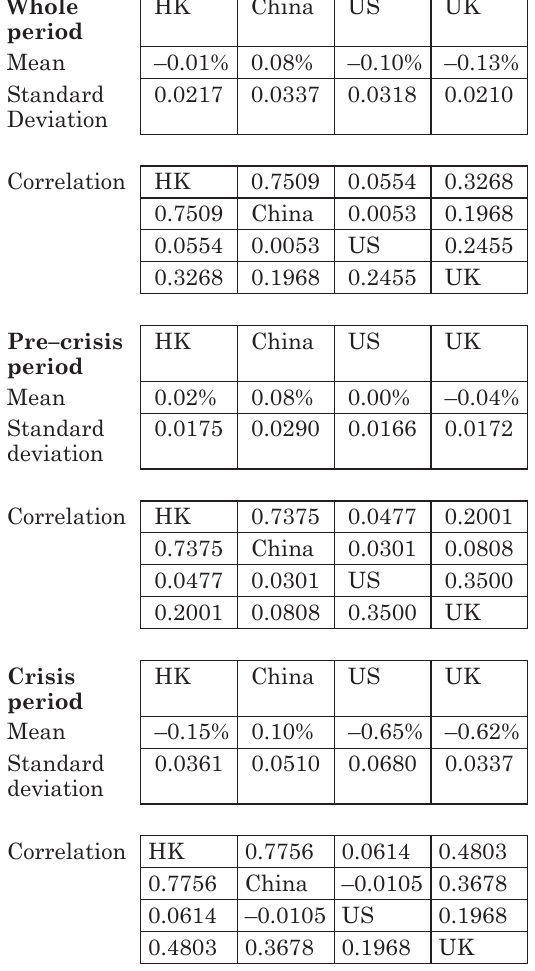
table 1. the mean, standard deviation and s throughout the whole correlation coefficients of , i t period, the pre-crisis period and the crisis period whole